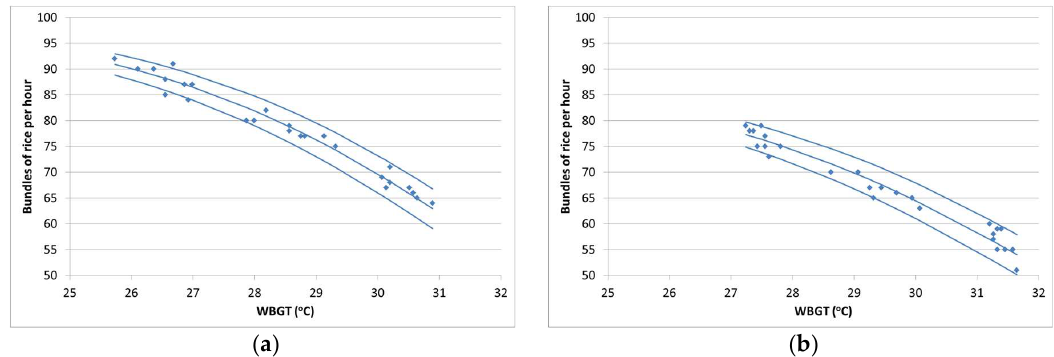
Figure 3. The data from Sahu (2013) [16]: hourly rice production in bundles/h (dots); fitted model and approximate 90% confidence intervals (lines). ( a ) First hour: T 0 = 0 °C, mean ψ = 100.0, SDτ = 1.04, slope b = −0.339, scale θ = 245; ( b ) Fifth hour: T 0 = 0 °C, mean ψ = 90.2, SDτ = 0.545, slope b = −0.316, scale θ = 183.